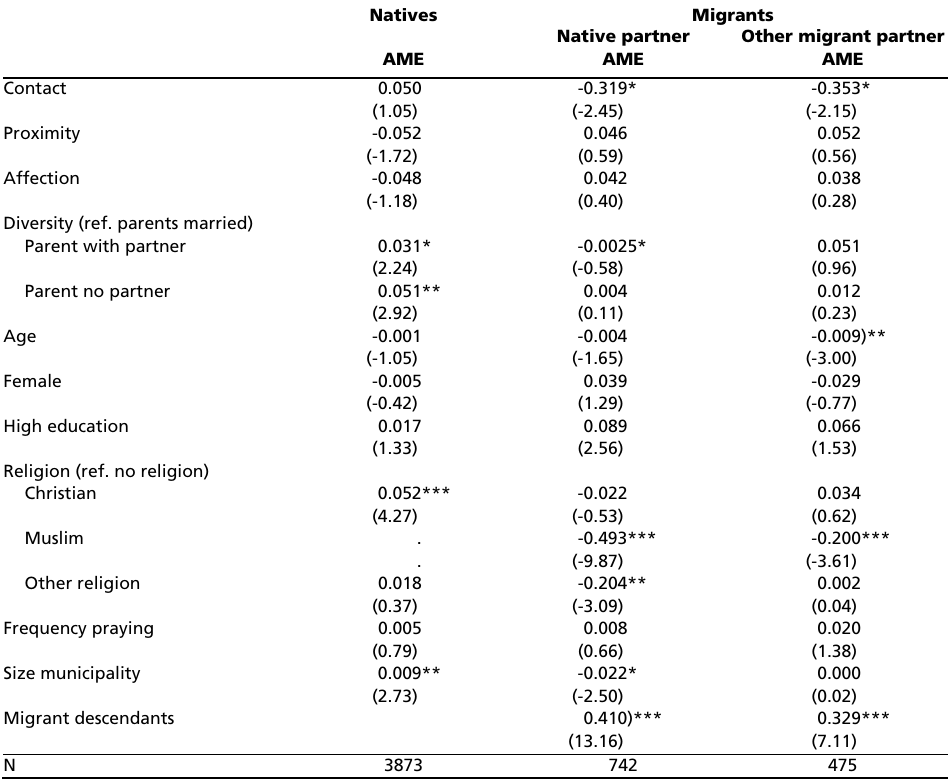
Table 3 : Models for interethnic partner choice of natives and migrants Natives Migrants Native partner Other migrant partner AME AME AME Contact 0.050)***